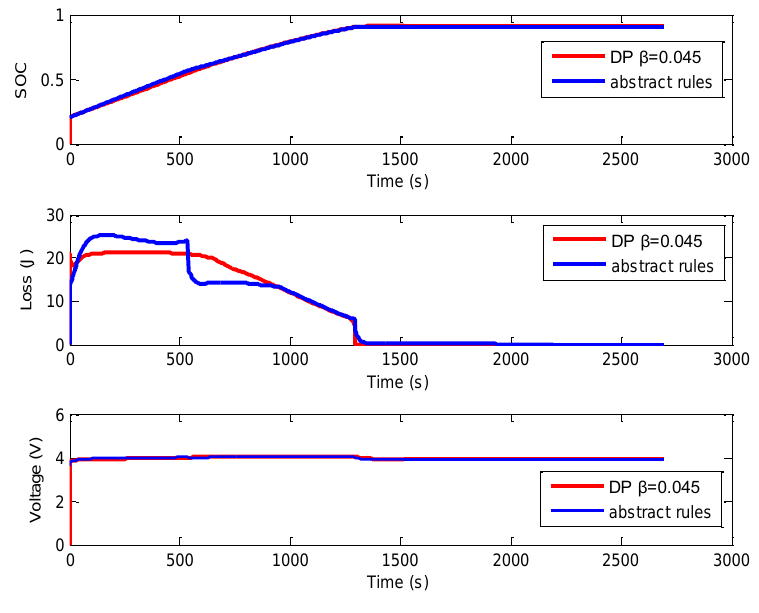
Figure 8. The performance of the abstracted charging